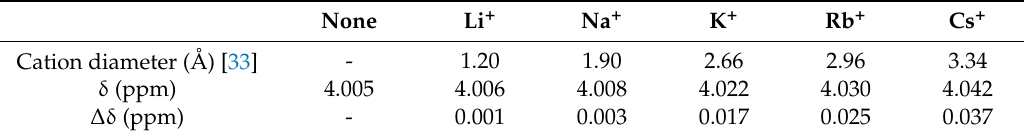
Figure 4. 1 H NMR spectra of P9 in the presence of alkali metal salt: ( a ) None; ( b ) LiCl; ( c ) NaCl; ( d ) KCl; ( e ) RbCl; ( f ) CsCl. Table 3. Chemical shifts ( δ ) and their changes ( ∆ δ ) of methylene protons of DB24C8 in P9 in the presence of alkali metal salt.